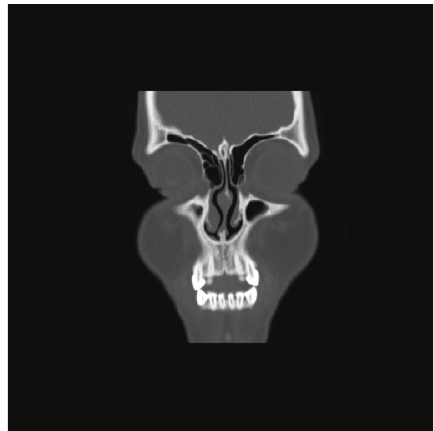
Figure 2: Coronal computed tomography section showing bilateral superior